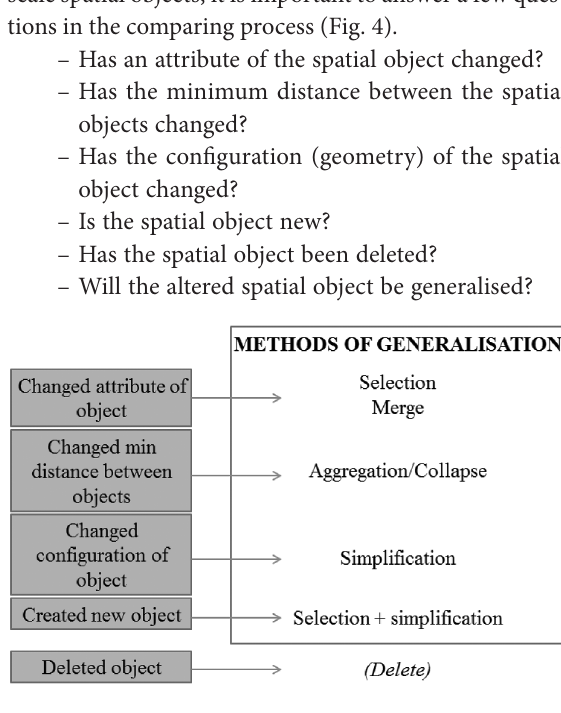
Fig. 4. Relation between detected change and process of